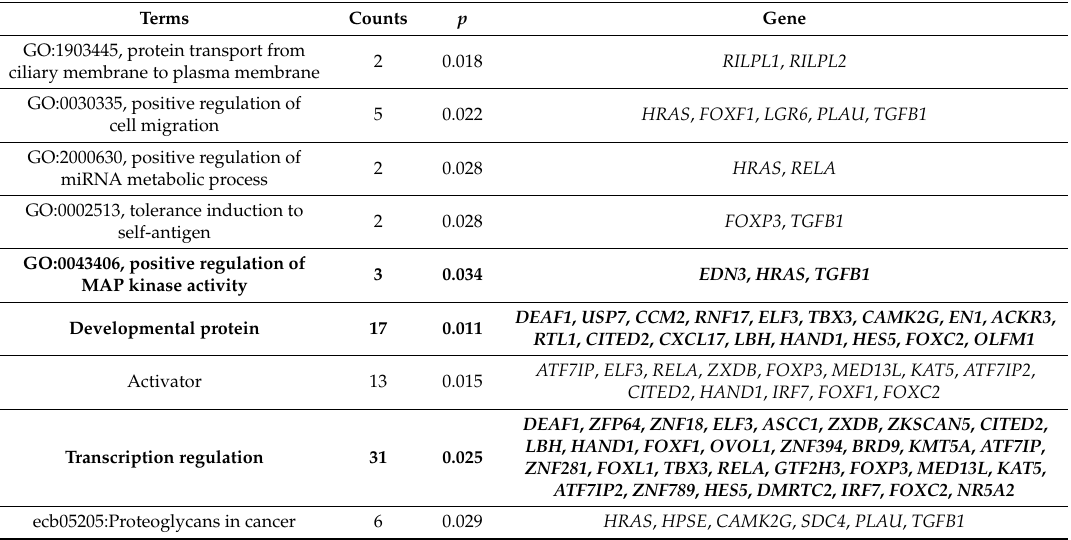
Table 3. Gene Ontology (GO) results of lncRNA targeted genes.